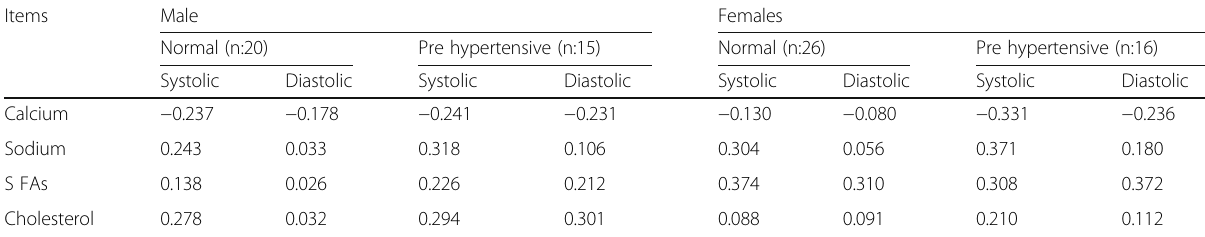
Table 5 Correlation coefficients between blood pressure (Systolic & Diastolic) and some of the daily nutrients intake of obese